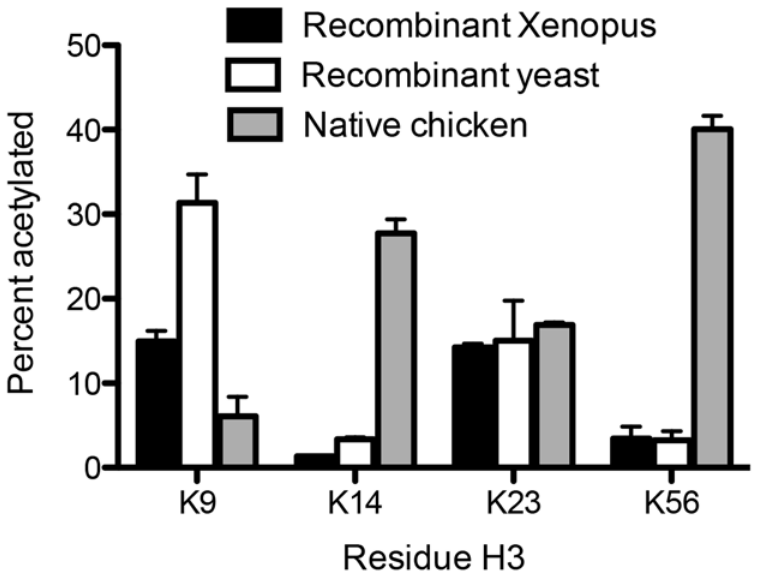
Fig 7. Comparison of Rtt109-Vps75 mediated acetylation (1-h incubation) on individual lysines on H3 from chicken erythrocytes, recombinant Xenopus histones, or recombinant yeast histones. Acetylation percentage of each site was determined by targeted MS-based method. The black and white bars depict the acetylation levels on recombinant Xenopus and yeast histones, respectively. The grey bar represents the acetylation levels on native chicken H3/H4 after 1 hour incubation with Rtt109-Vps75. The error bar represents the standard deviation in acetylation percentage from triplicate measurements. Note that the acetylation amount on both recombinant histones is initially negligible; however, there is ~25% H3K14ac and ~12% H3K23ac preexisting acetylation on chicken histones.